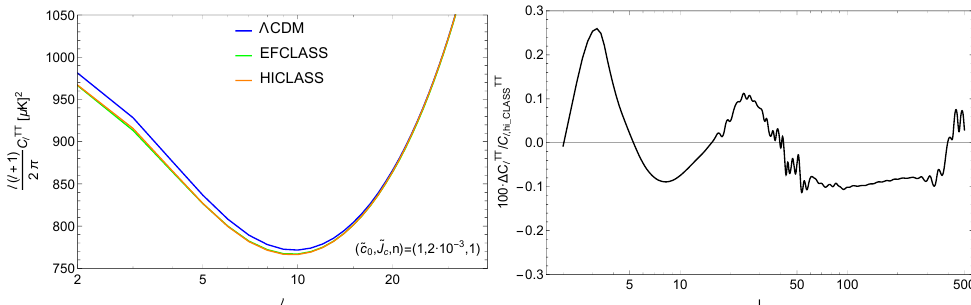
Figure 3. ( Left ) The TT CMB spectrum for Ω m,0 = 0.3, n s = 1, A s = 2.3 · 10 − 9 , h = 0.7 and − 3 ,1 ) . The results of the EFCLASS code are denoted by the green line, those of ˜ J ( ˜ c c , n ) = ( 1,2 · 10 0 , hi_CLASS by an orange line and for the Λ CDM with a blue line. ( Right ) The percent difference of our code with hi_CLASS. Image from Ref.